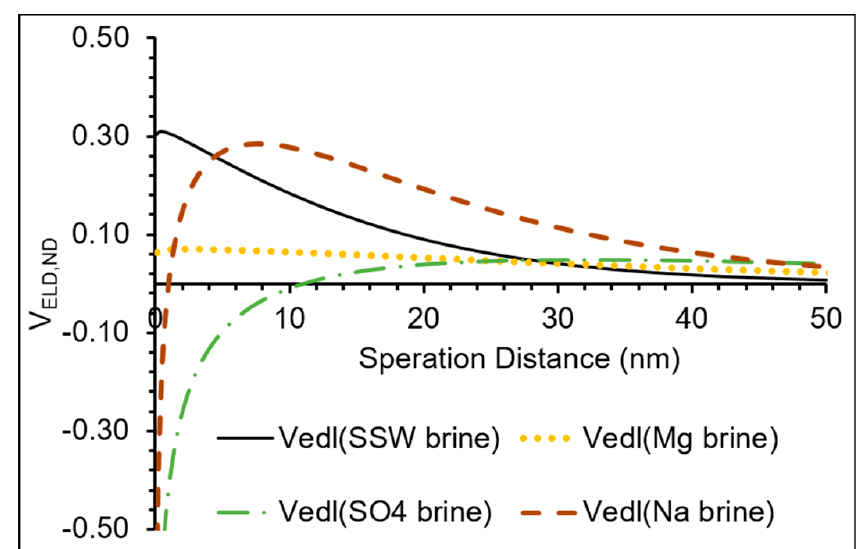
Figure 5. Double layer interactions for NPs/mineral surfaces in different brines.